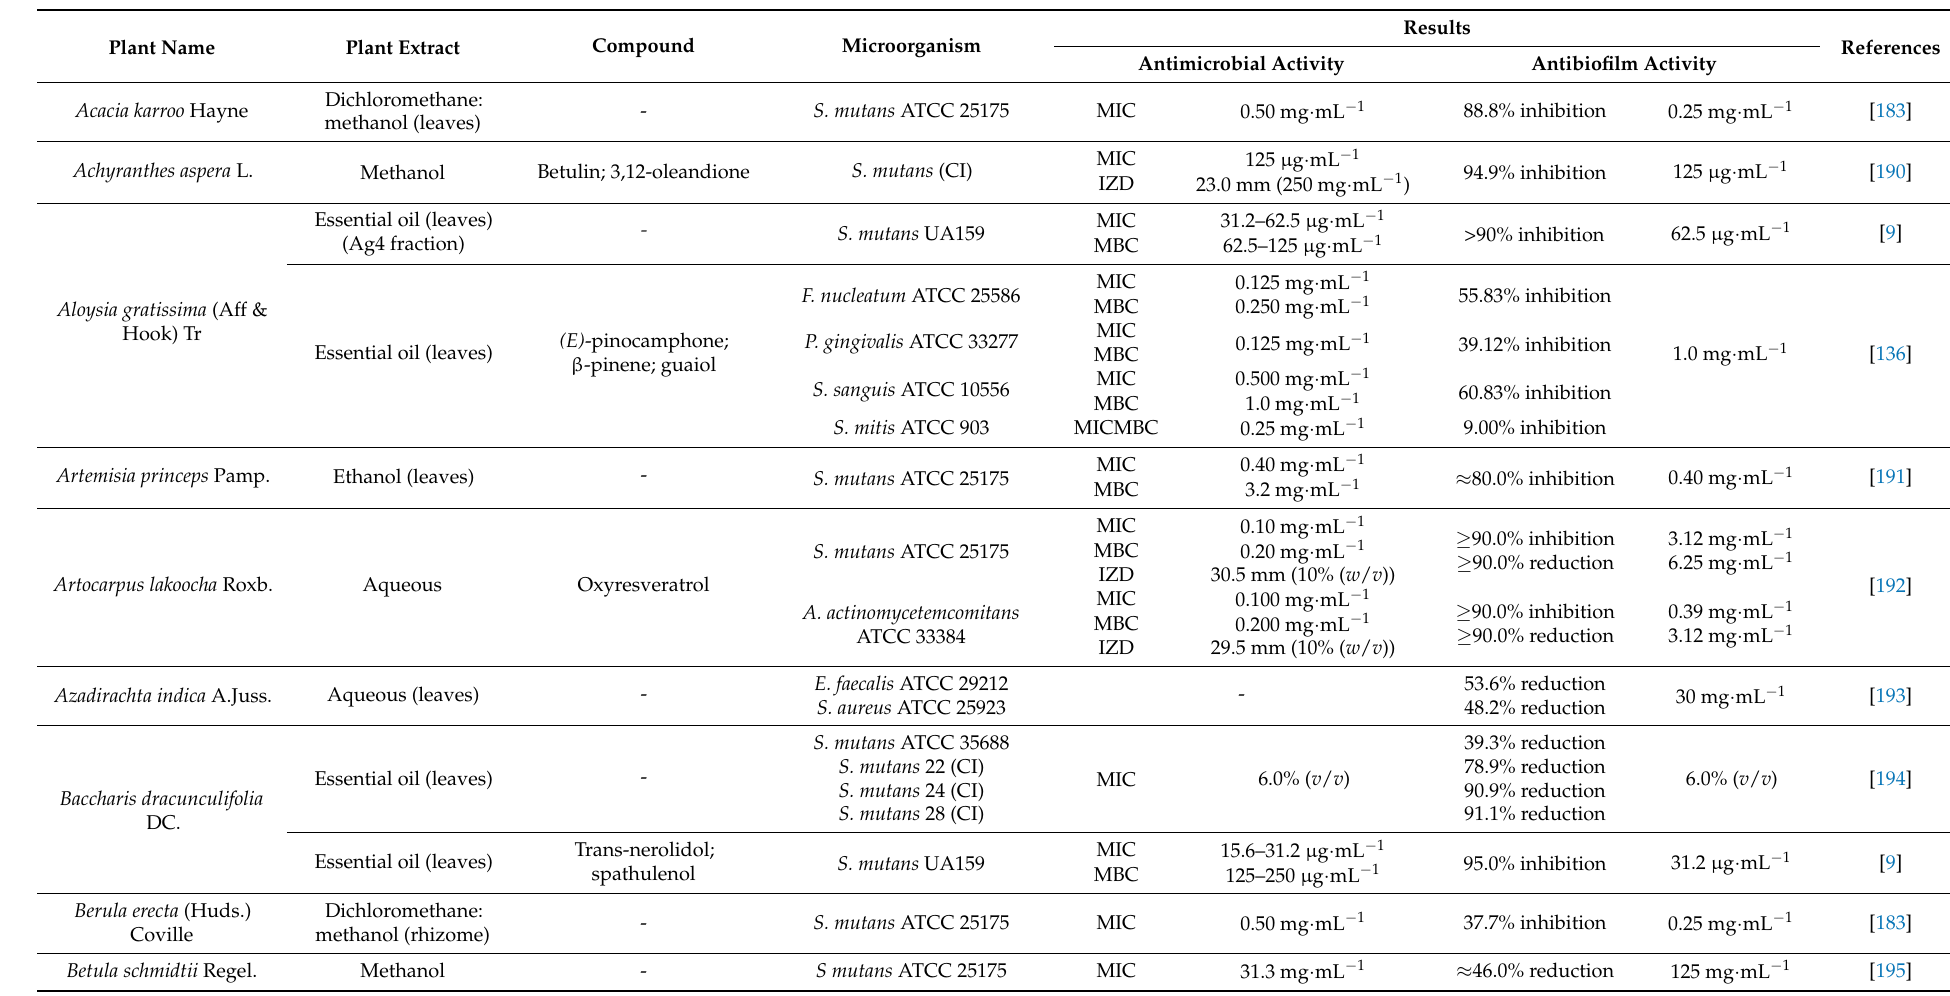
Table 1. Medicinal plants with verified antimicrobial/antibiofilm activity against oral cavity bacteria, and the respective bioactive compounds present in their